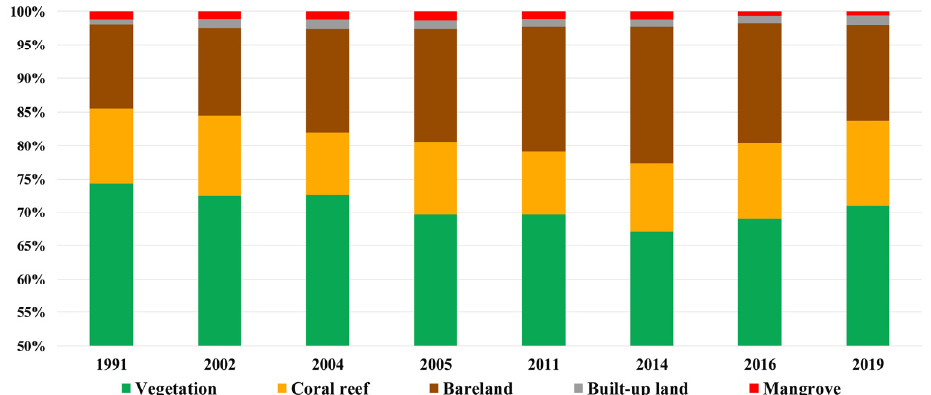
Figure 3. Percentage of stacked land-use types in Fiji from 1991 to 2019. (Coral reef area data in 1991 were replaced by average value).